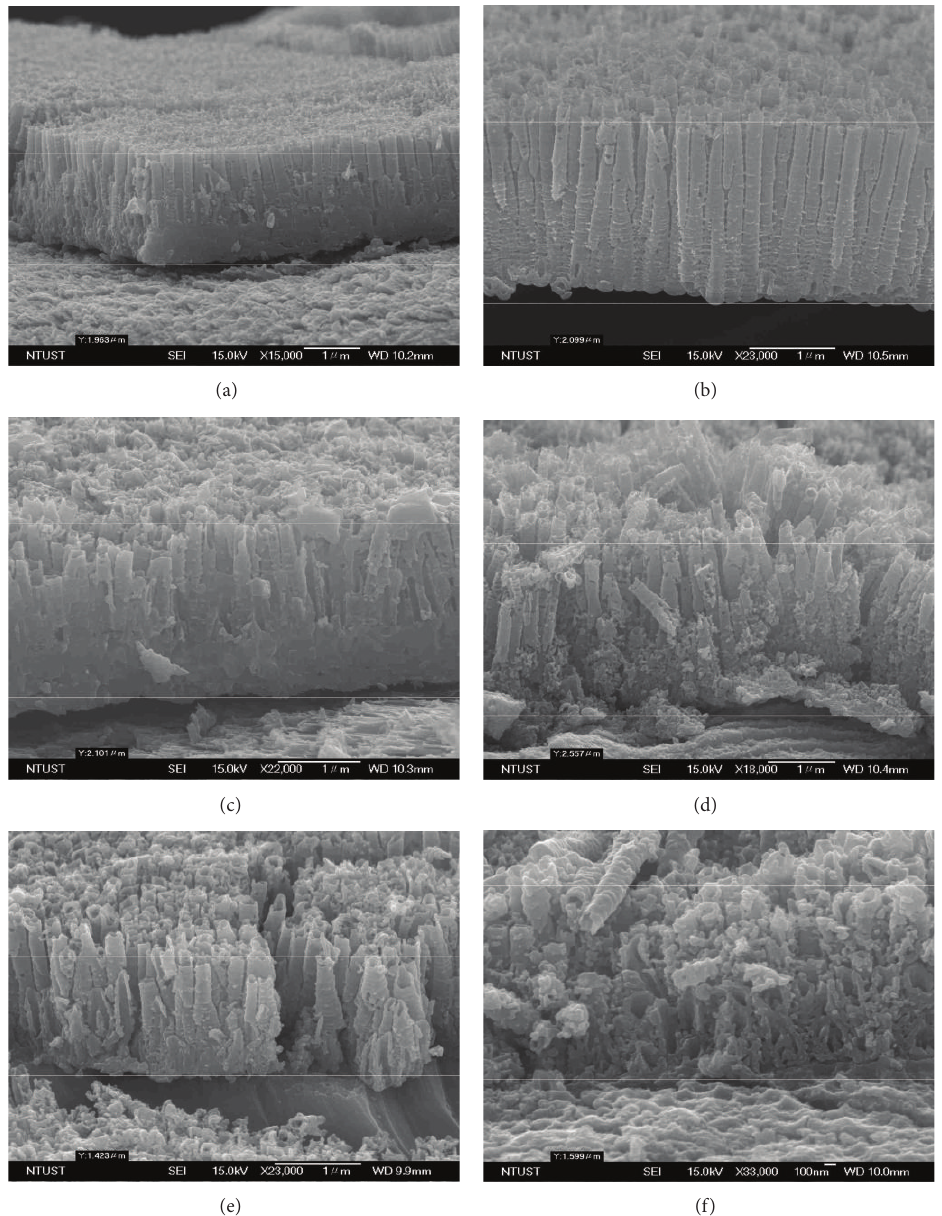
Figure 5: Front view of SEM images of TNT synthesized at different electrocatalysis time: (a) 1hr, (b) 2hr, (c) 4 hr, (d) 6 hr, (e) 8hr, and (f)